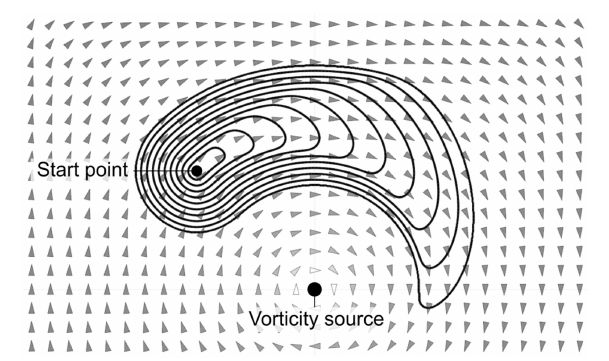
FIGURE 2 | Example application of the pyrogenic potential model with vortex source term to a dynamic wildfire simulation. The black lines show isochrones of a fire perimeter and the arrows show the resultant wind field from the vorticity source.